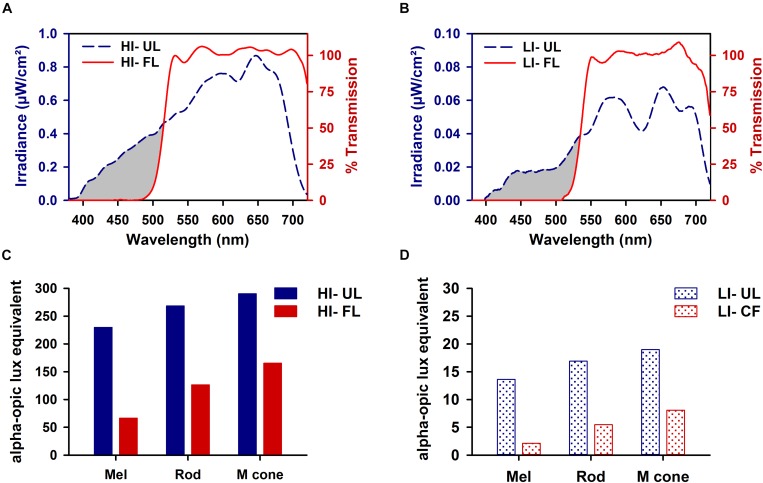
Spectral transmission profiles of high irradiance (HI ∼100 μW/cm2; A) and low irradiance (LI ∼10 μW/cm2; B) filtered polychromatic light. Transmission profile of filtered light (FL; red line) shown against the tungsten-halogen unfiltered light source (UL; blue dashed line) display the removal of all visual short wavelengths < 500 nm (represented by the gray-shaded region). Corresponding representation of melanopsin (λmax 480 nm), rod opsin (λmax 498 nm), and M-cone opsin (λmax 508 nm) photoreceptor activity produced under HI (C) and LI (D) FL and UL conditions.